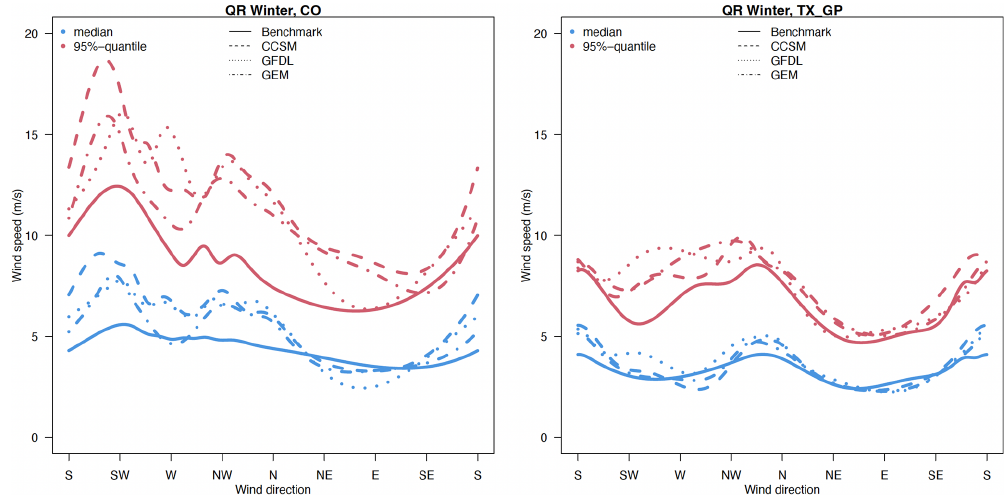
Figure B1. Quantile regression in winter during 1995–2004 at two selected locations as an example for the summary metrics